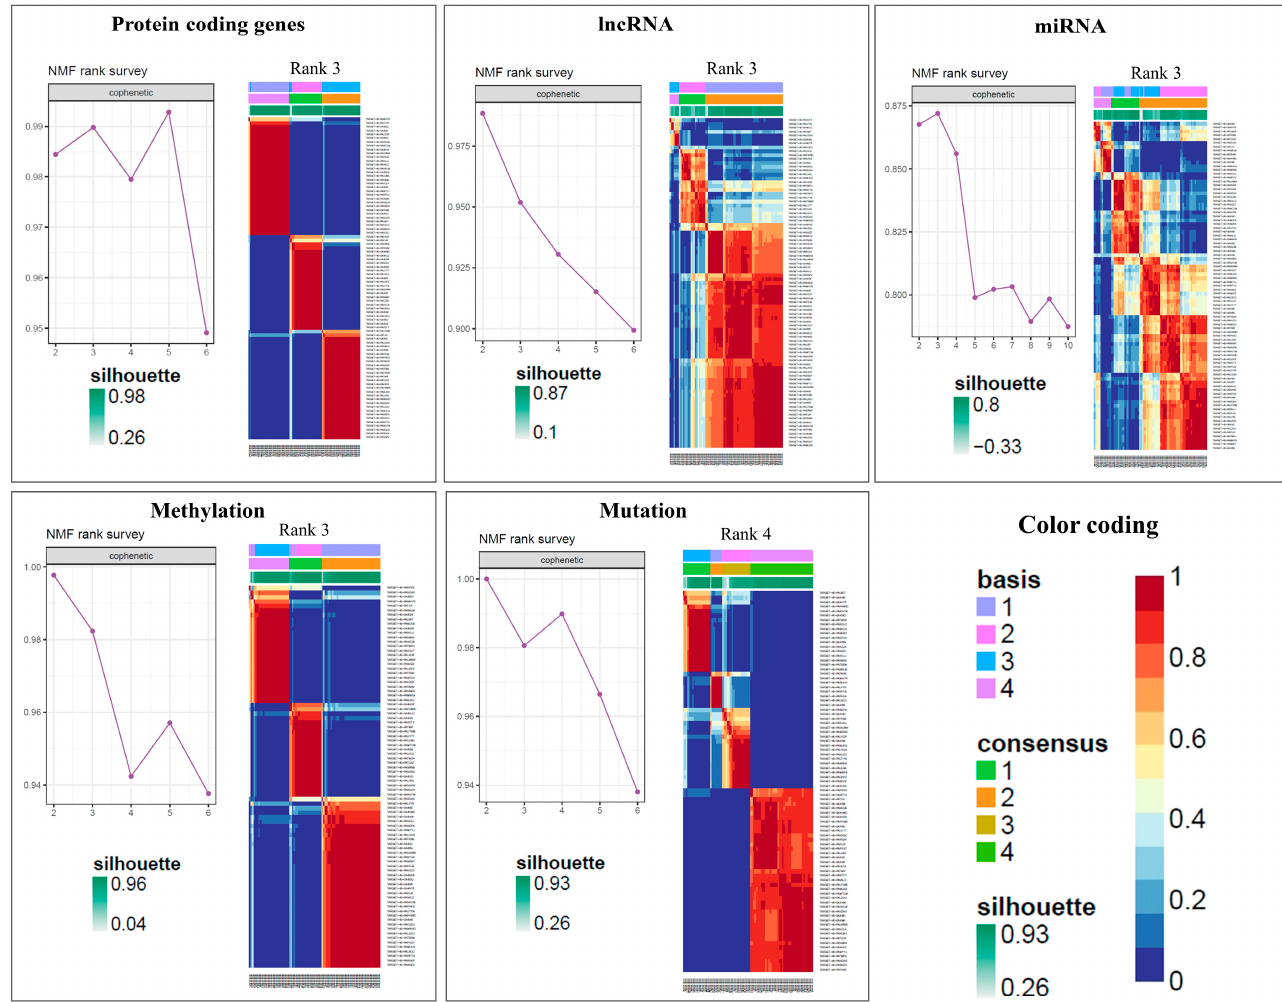
Figure 4. Average silhoue tt e width and NMF classi fi cation with rank using 190 miRNAs, 1107 mu- tations, 2500 protein-coding regions, 500 lncRNA, and 5000 CpG methylation probe data for 85 OS- TARGET patients which was further used as input for COCA for obtaining the fi nal two